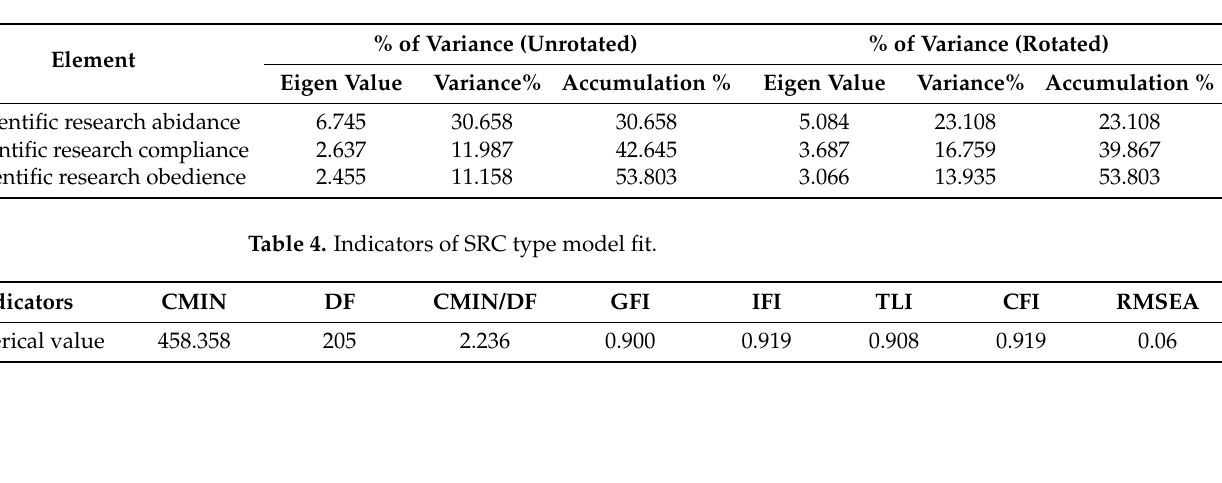
Table 3. Explanation of total variance.